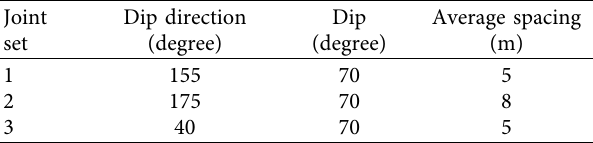
Figure 3: The 3DEC model of the Jurong pumped storage power station project. Random blocks simulation result (a); the rock mass model is processed transparent to make the project location clear (b). Inner structures of the caverns (c); excavation sequence scheme of the underground cavern complex (d). Table 1: Statistical results of strongly developed joint sets.